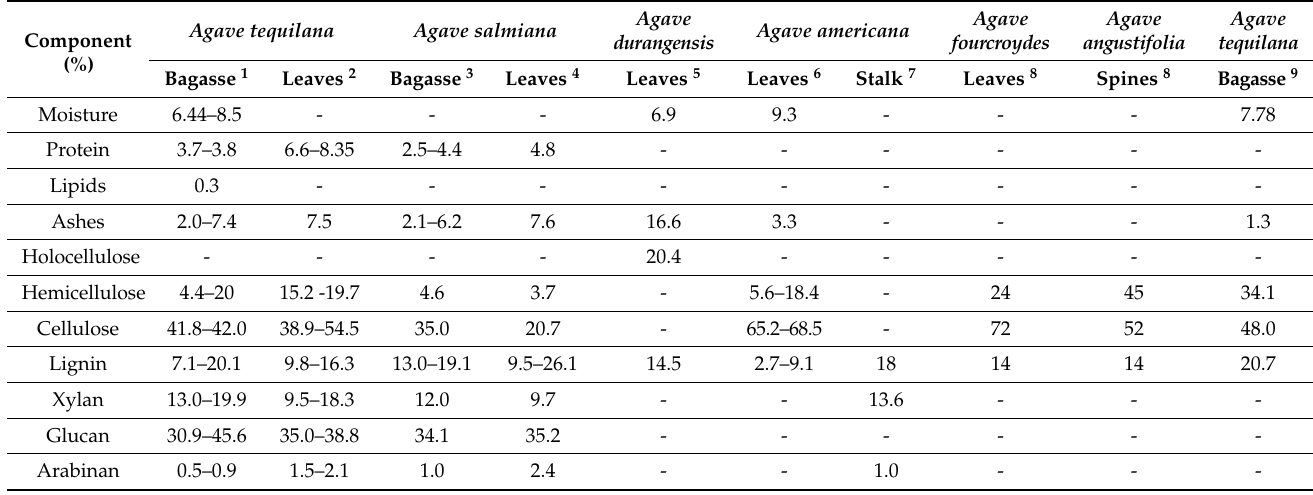
Table 1. Chemical composition of agave